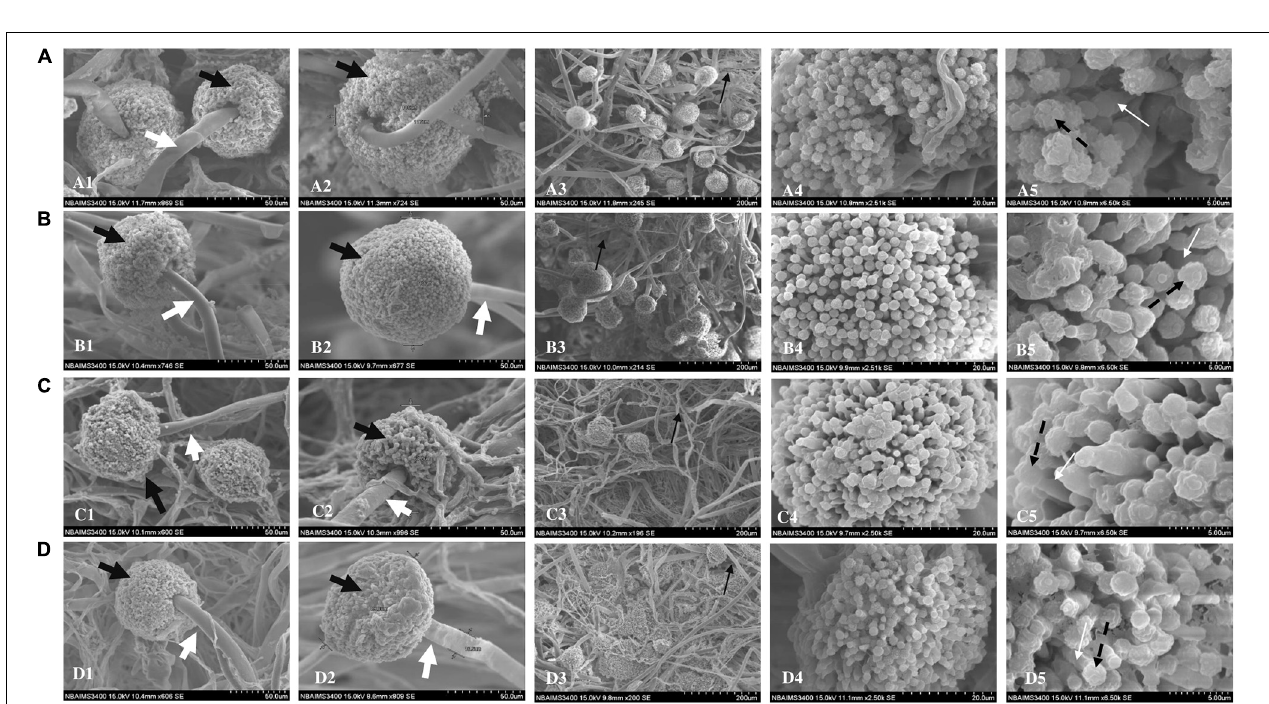
FIGURE 3 | LPCB stained fungal hyphae treated with varying concentrations of siderophore: 1—no siderophore, 2—18 µ g/ml, 3—36 µ g/ml, 4—44 µ g/ml (asterisk—apical branching; arrow—lateral branching; magnification—100 × ).